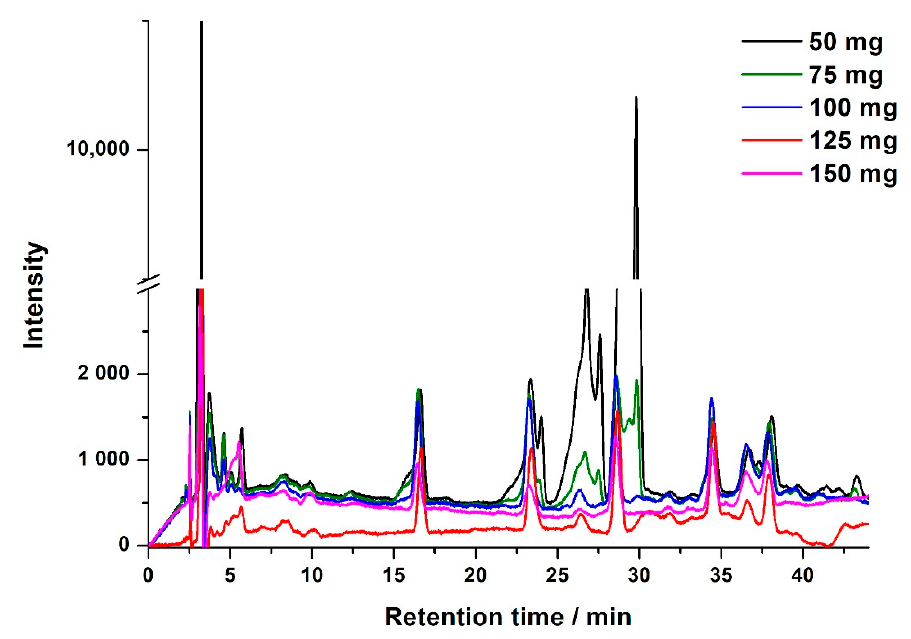
Figure 3. Representative chromatograms of extract cleaned up by DPX tips with different masses of PSA.